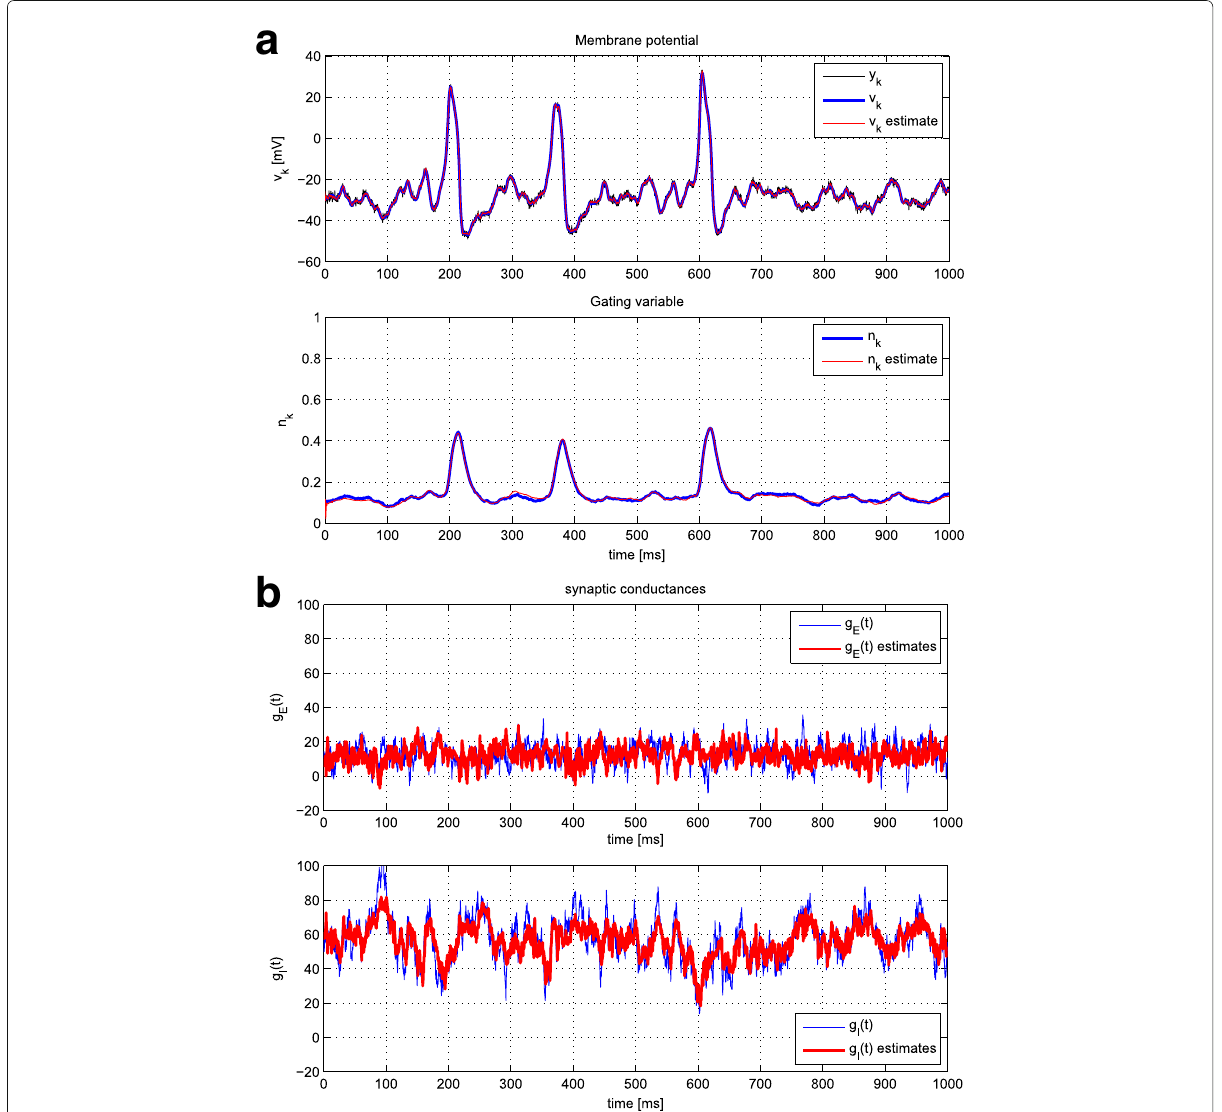
Fig. 8 A single realization of the PF method with perfect model knowledge, estimating voltage, and gating variables ( a ) and synaptic conductances in nS ( b ). See Table 3 for the true value, initial value, and covariance of the parameters used here